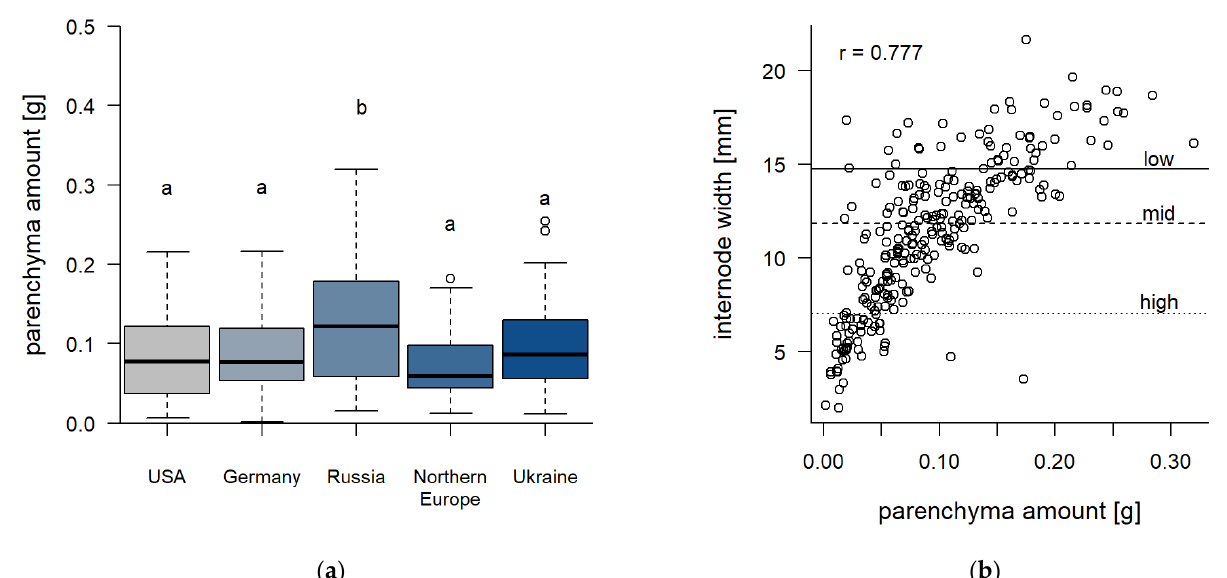
Figure 4. Qualities of different European cup plant accessions. The data presented were acquired by surveying internode segments of 5 cm length. Three internodes in different heights (high, mid, low) were examined per stem. In total five accession (‘USA’, ‘Germany’, ‘Russia’, ‘Northern Europe’, ‘Ukraine’) with 18 stems each were analyzed. ( a ) Boxplots ( n = 54) of parenchyma amounts as a function of their accession. The letters above represent homogenous groupings, calculated via ANOVA with following post hoc test (Tukey-HSD). Different letters indicate significance at p < 0.05. ( b ) Scatterplot of internode width against parenchyma amount ( n = 270). The correlation coefficient of both parameters equals 0.777 over all five accessions. Horizontal lines display the arithmetic means of internode widths on different positions on the shoot (independent of accession).